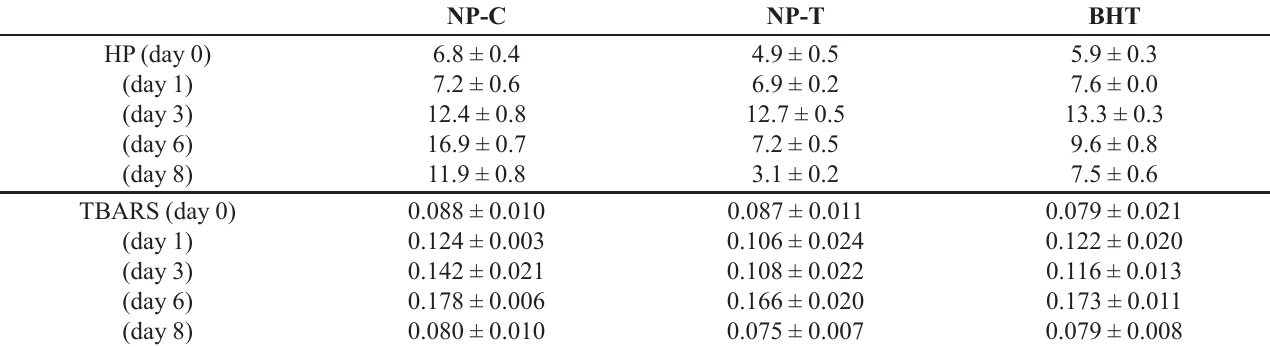
TABLE II - HP (meq hydroperoxides per kg oil) and TBARS (1/mg) values of mayonnaise samples stored at 63 o C for 8